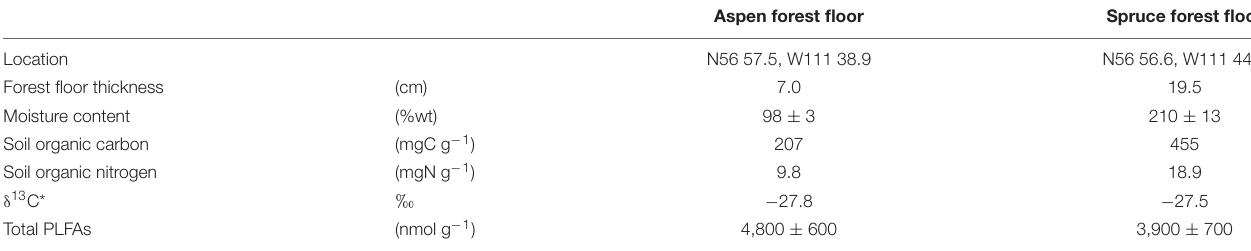
TABLE 1 | Key properties of the aspen and spruce forest floor materials used during the 67-day laboratory incubation.